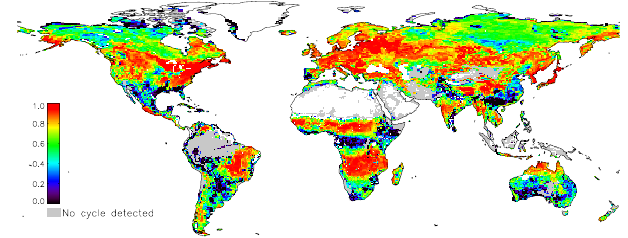
Fig. 2. Correlation map between the NDVI and the FPAR monthly time series for the 2000–2008 period and the ERA-I simulation with the new phenology scheme. The correlation is not calculated when no annual cycle in the NDVI and FPAR is detected (grey areas).